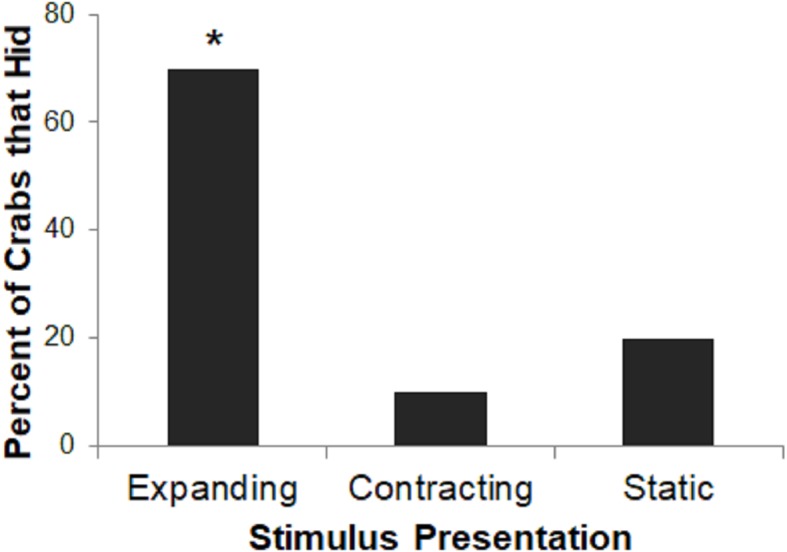
Percent of crabs that hid to the Expanding, Contracting, and Static conditions in Experiment 1.Asterisk indicates significant difference from remaining groups, p < .05.